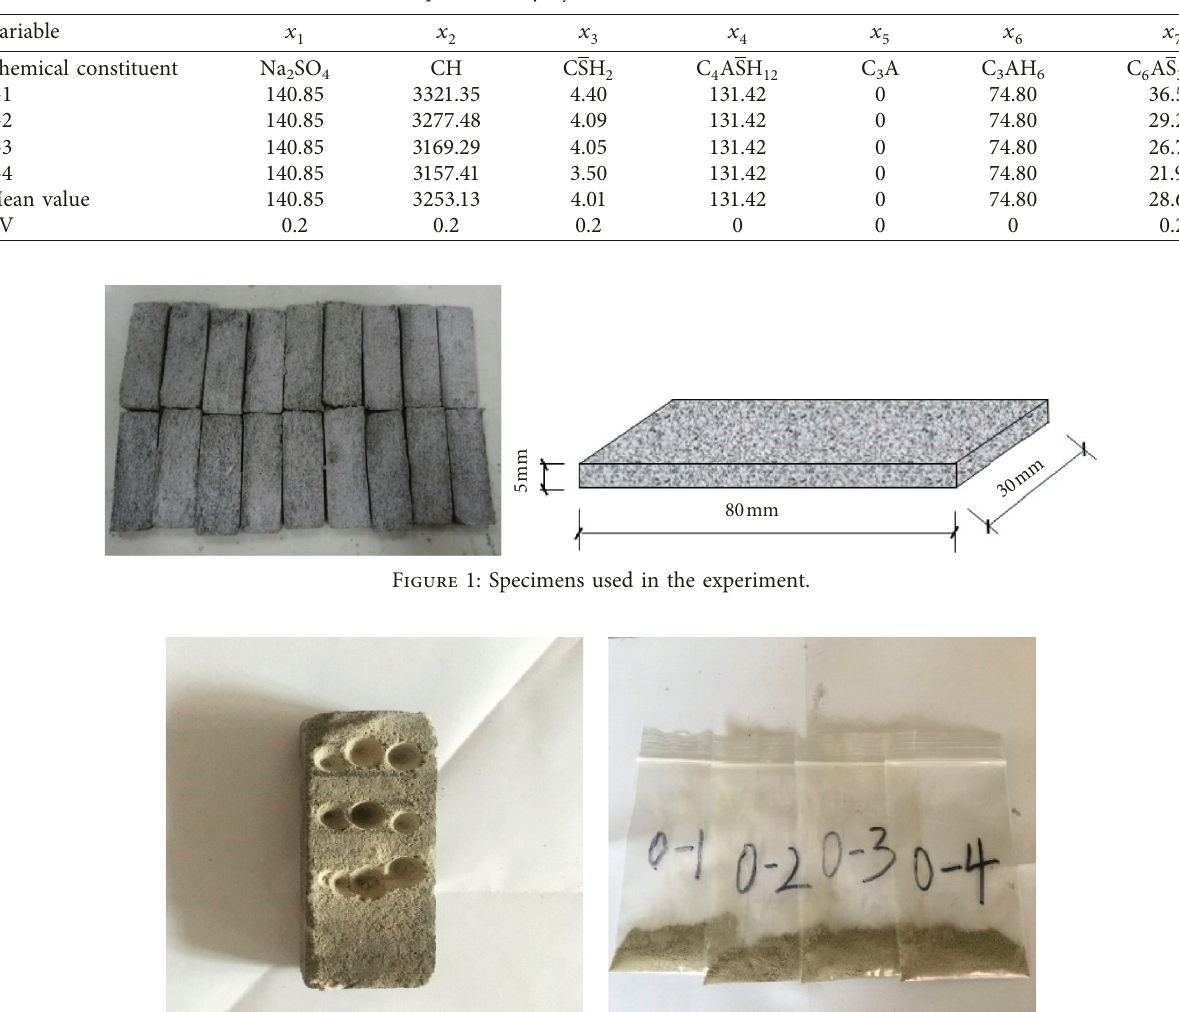
, i � 1 , 2 , ... , 7 and their initial concentrations (mol/m 3 ). i